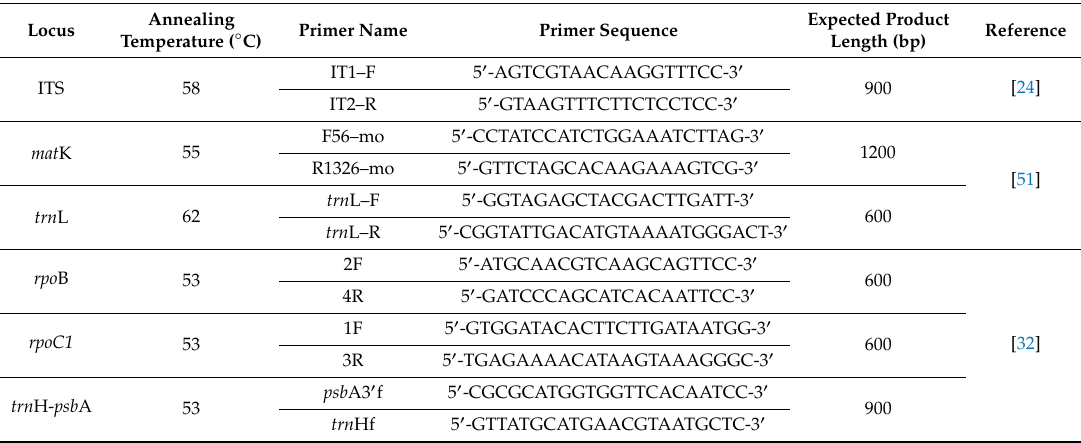
Table 1. Primers used for amplification reactions in the